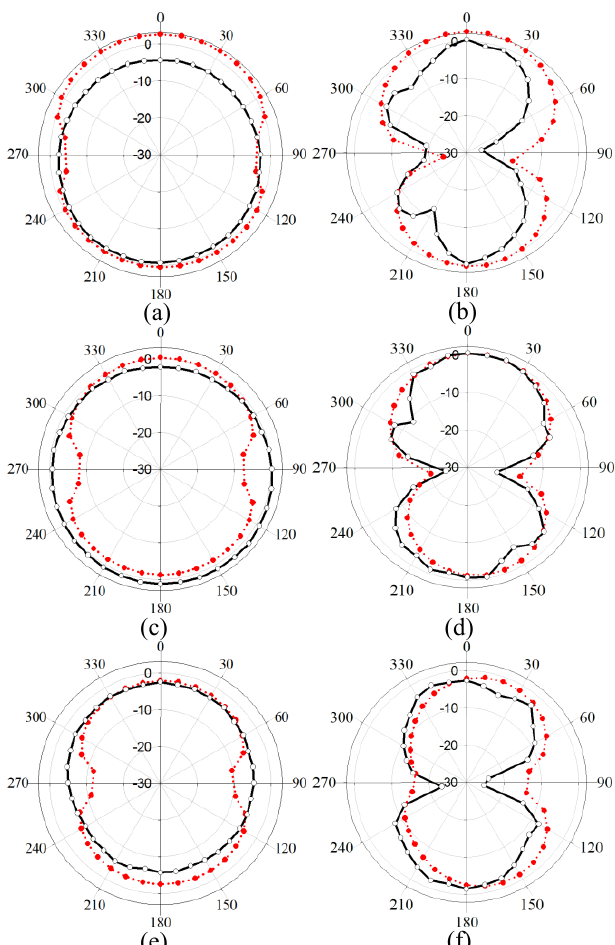
Figure 6: Simulated and measured radiation patterns of the LPMA at (a) 5 GHz for xz -plane (b) 5 GHz for yz -plane (c) 5.8 GHz for xz -plane (d) 5.8 GHz for yz -plane (e) 7 GHz for xz -plane (f) 7 GHz for yz -plane ( shows simulations, shows measurements)